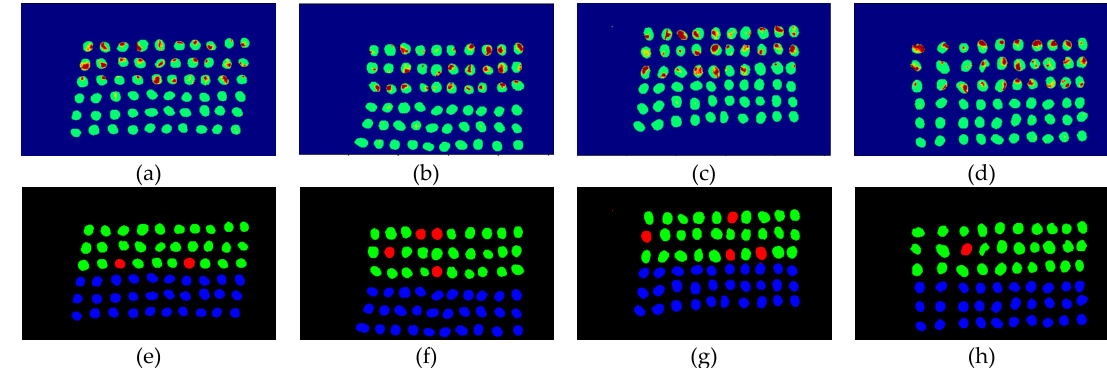
Figure 39. Results of green coffee bean CEM-SVM+MinV_BP 20 bands. (a-d) SVM classification results, (e-h) final visual images.